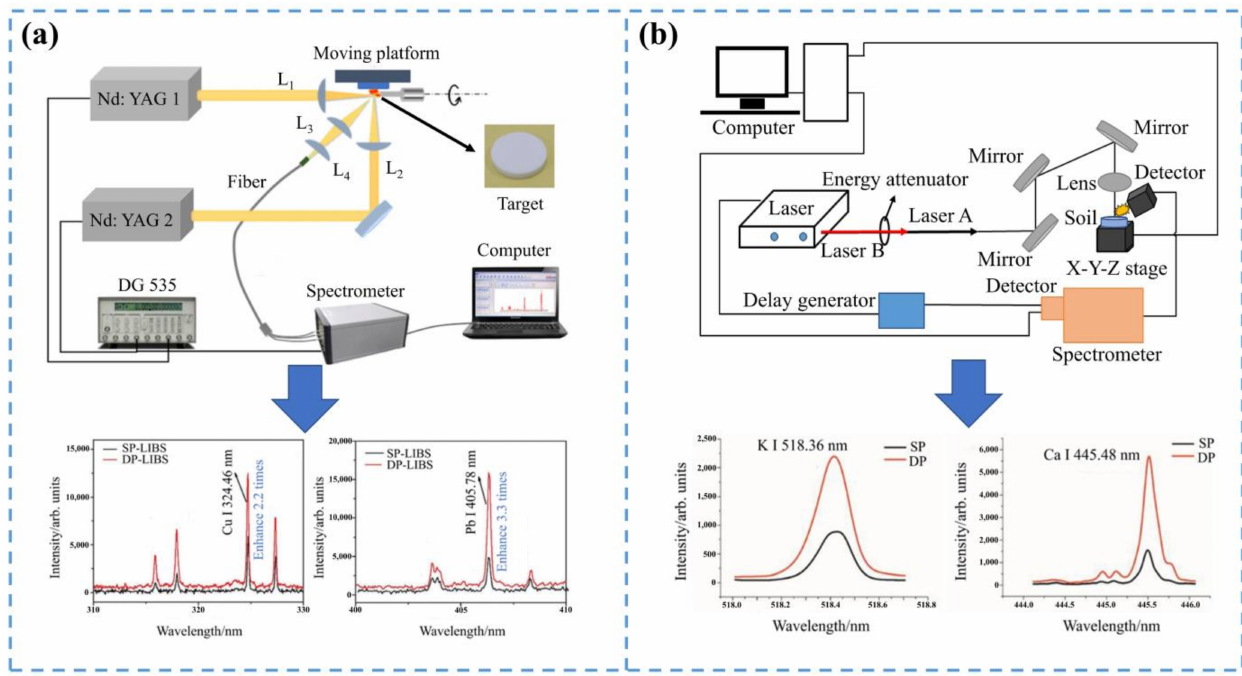
Figure 4. The double-pulse-enhanced LIBS signal device. ( a ) ODP-LIBS; ( b ) CDP-LIBS. ODP-LIBS consisted of the first laser acting on the sample surface to excite the plasma, adjusting the appropriate delay time, and the second laser perpendicular to the first